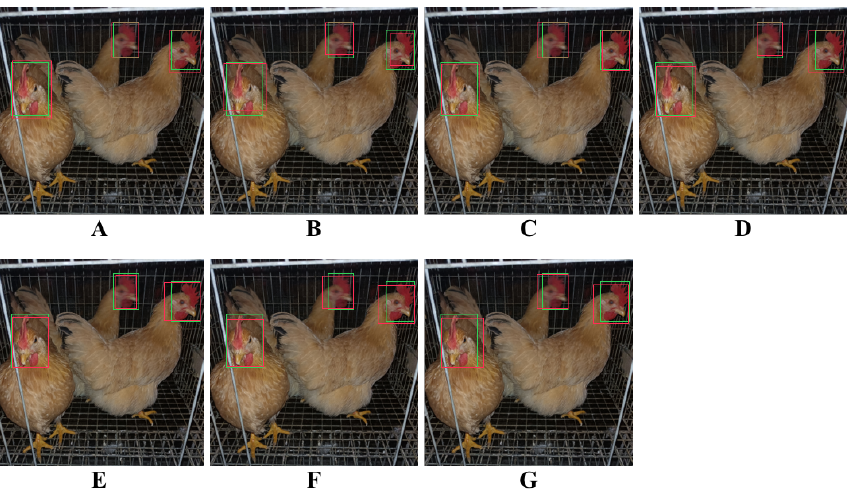
Figure 10. Illustration of detection outcomes from different detection models. ( A ) This study, ( B ) Faster RCNN, ( C ) Mask RCNN, ( D ) YOLOv3, ( E ) YOLOv5, ( F ) SSD, and ( G ) EfficientDet.